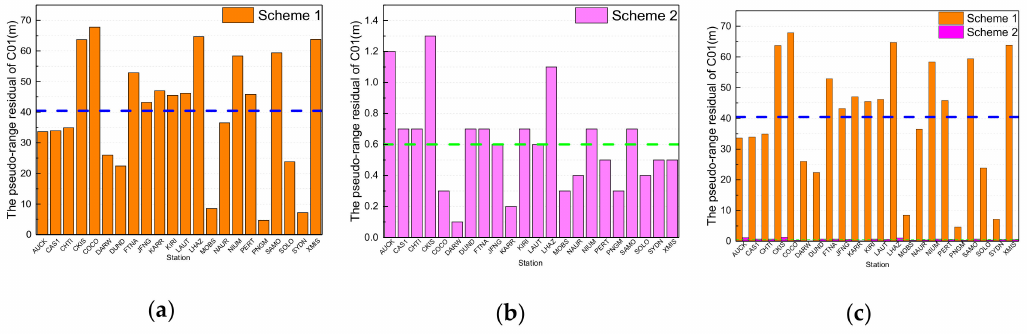
Figure 3. Pseudo-range residuals of stations for C01 in the first adjustment for data processing on 9 January 2017: residuals from precise orbit determination according to ( a ) scheme 1 and ( b ) scheme 2 and ( c ) comparison between Figure 3a,b.